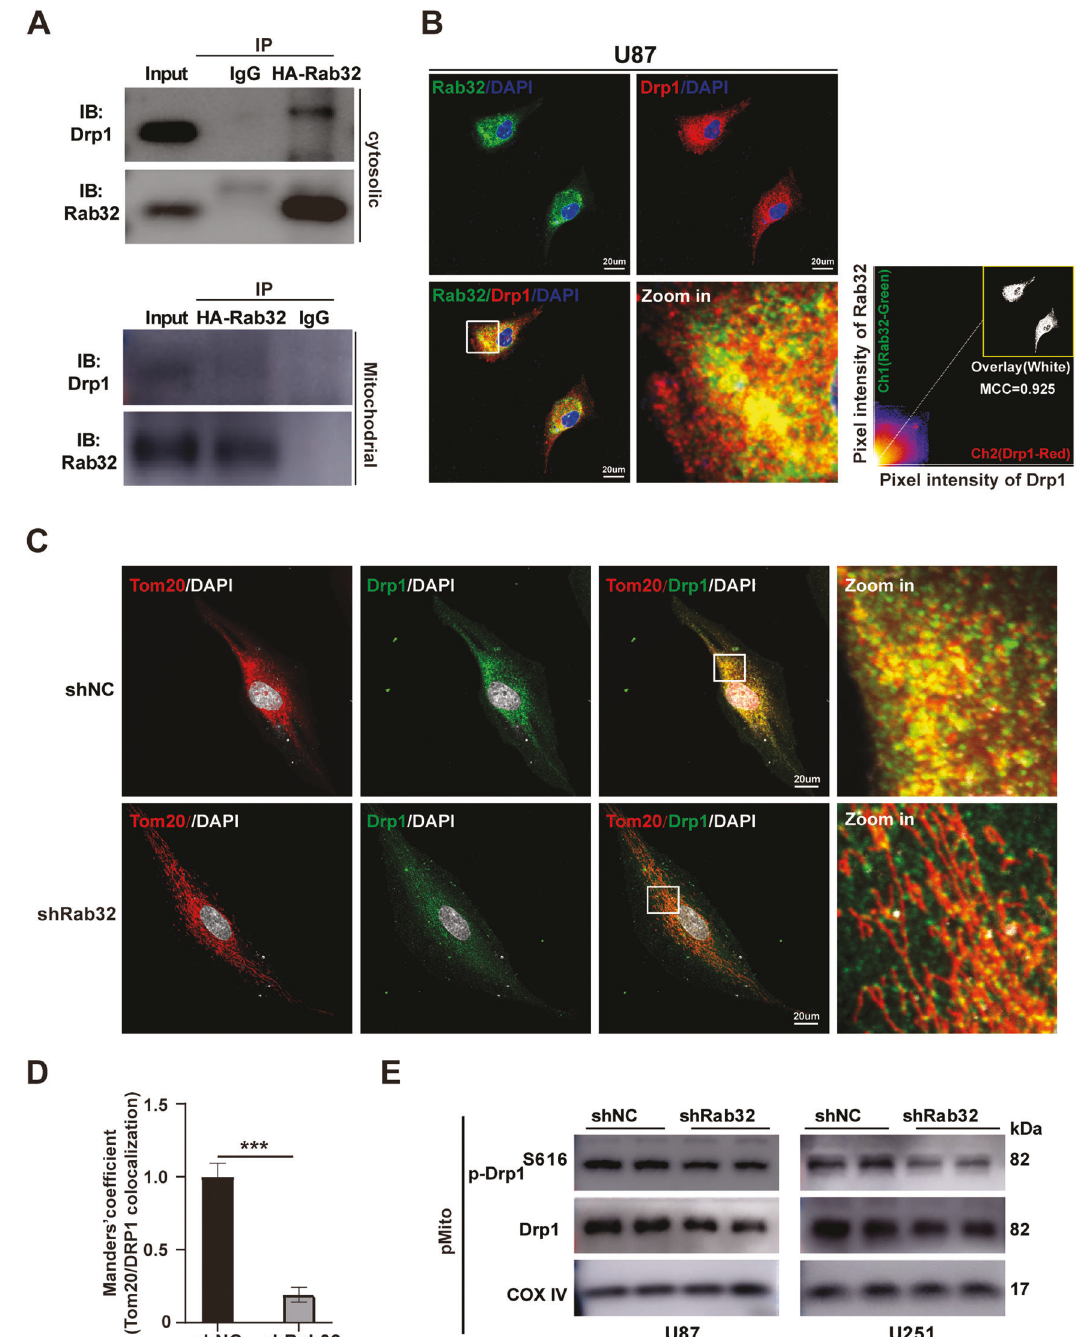
Fig. 5 Rab32 transports Drp1 from the cytoplasm to the mitochondrial. A Immunoprecipitation assay evaluated the Rab32 interacted with Drp1 in the cytoplasm or on mitochondria. Rabbit IgG was used as a control. B Co-localization of Rab32 with Drp1 had been analyzed using immuno fl uorescence staining in treated U87 cells. The level co-localization was quanti fi ed by Manders Co-localization Coef fi cient (MCC) values using ImageJ software. Green: Rab32, Red: Drp1, Blue: DAPI. Scale bar = 20 μ m. C , D Representative images and quanti fi cation of co- localization of Drp1 with mitochondria in treated U87 cells. Green: Drp1, Red: Tom20, White: DAPI. Scale bar = 20 μ m. E Western blot analysis for protein expression of total Drp1 and p-Drp1 S616 in mitochondrial fraction of U87 and U251 cells. COX IV was used as a control. The data are shown as the mean ± SD of three replicates. *** P < 0.001 vs. NC groups. their potential interaction interfaces, and our data showed that Firstly, we found that silencing Rab32 reduced the level of Rab32 interacted with ERK 1/2 (Fig. 6C). We further performed phosphorylated ERK 1/2 while the total ERK 1/2 did not change dramatically in U87 and U251 cells (Fig. 6A and S6A). On the Co-IP experiment and our result con fi rmed that Rab32 contrary, over-expression of Rab32 promoted phosphorylation interacted with ERK 1/2 (Fig. 6D). These data revealed that and activation of EKR 1/2 (Fig. 6B and S6B). Moreover, we Rab32 interacted with ERK 1/2 and activated ERK 1/2 signaling applied the PRISM tool (http://cosbi.ku.edu.tr/prism) to predict pathway. Cell Death and Disease (2023)